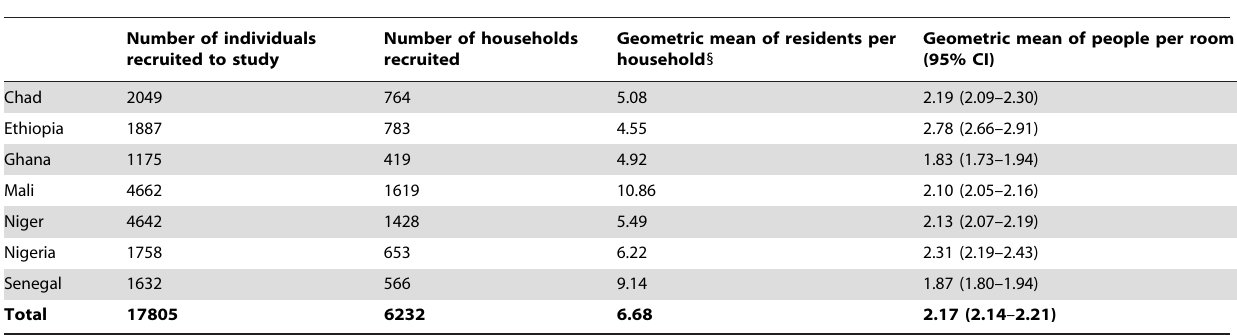
Table 1. Summary of household data and crowding by country.